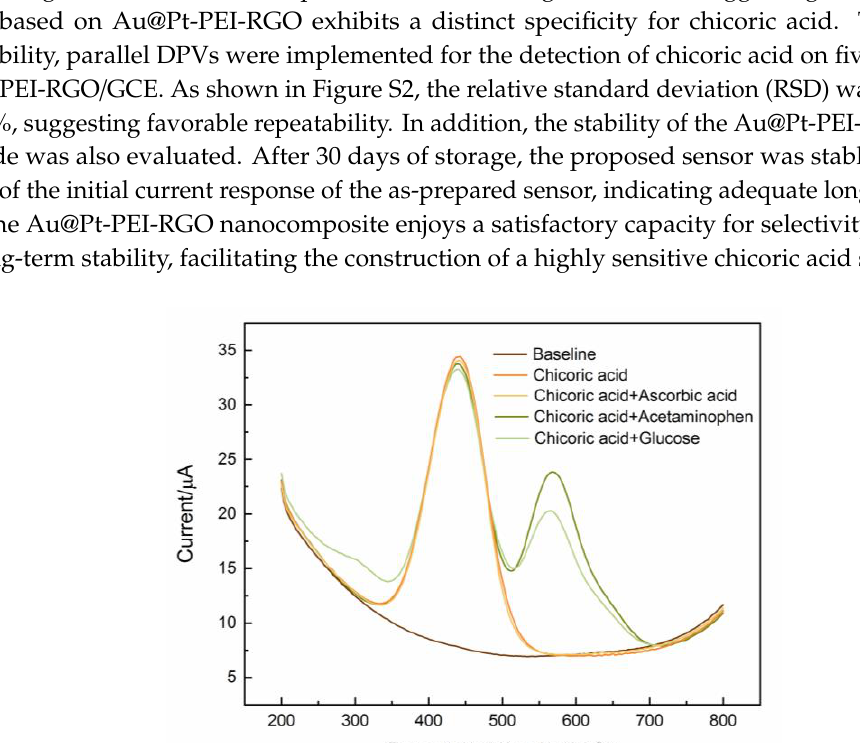
Table 1. Comparison of the reported methods for chicoric acid determination. PEI, polyetherimide; RGO, reduced graphene oxide.